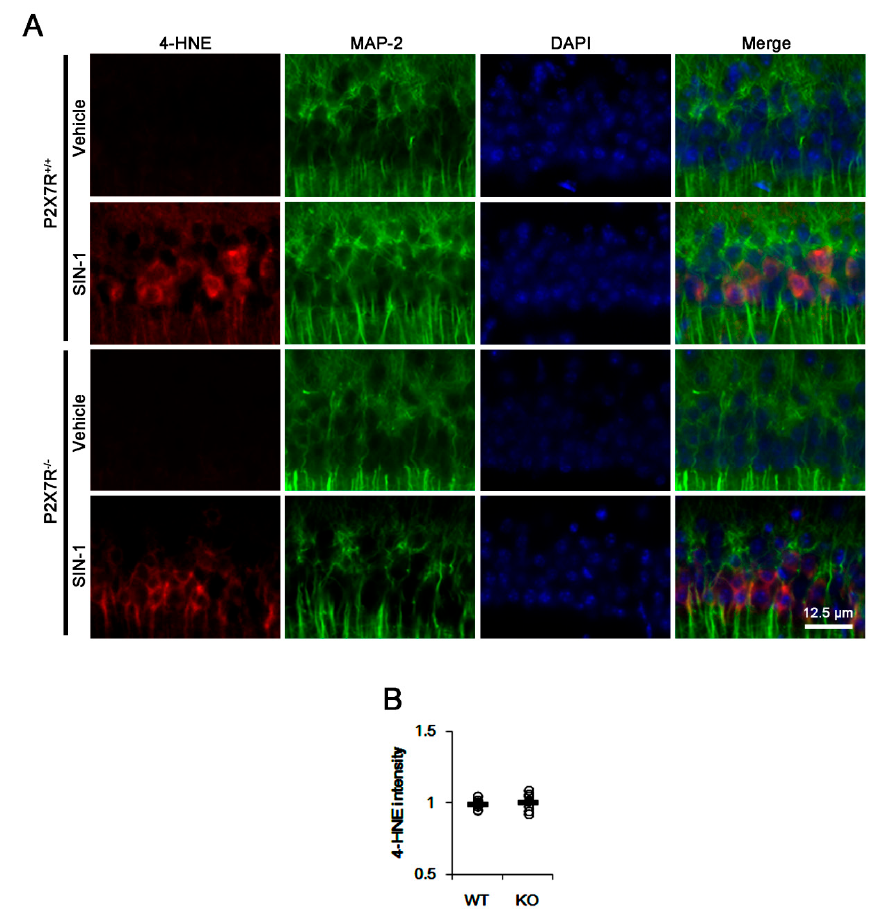
Figure 5. Effects of P2X7R deletion on 4-HNE synthesis induced by SIN-1. SIN-1 induces 4-HNE signals in the CA1 regions. P2X7R deletion does not affect 4-HNE signals after SIN-1 treatment. ( A ) Representative images of 4-HNE induction. ( B ) Quantification of 4-HNE fluorescent intensity. Open circles indicate each individual value. Horizontal bars indicate mean value (mean ± S.E.M.; n = 7, respectively).